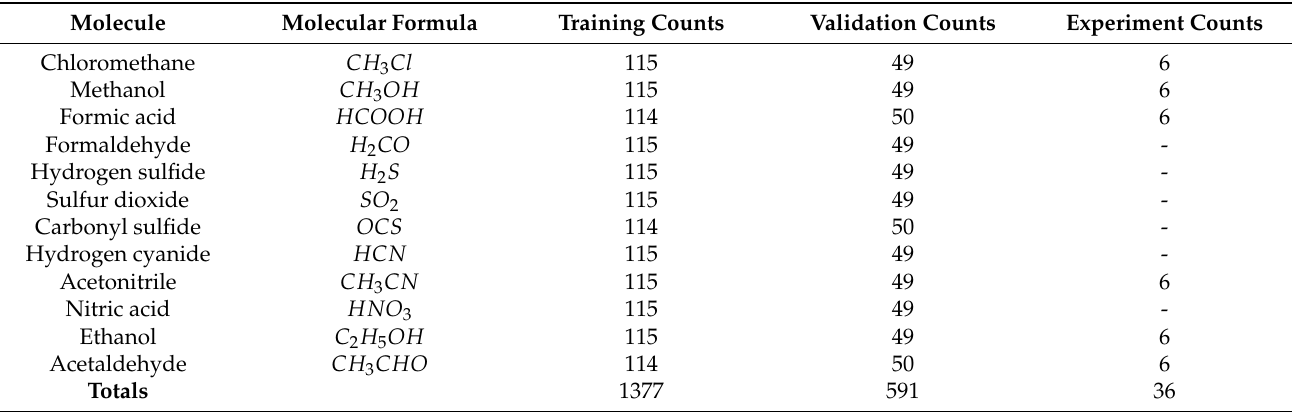
Figure 3. Data analytics for simulated training and validation spectra and experimental spectra. Table 1. Number of spectra in training, validation, and experimental